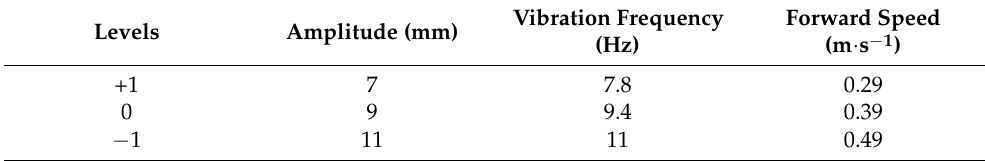
Table 2. Test factors and levels.